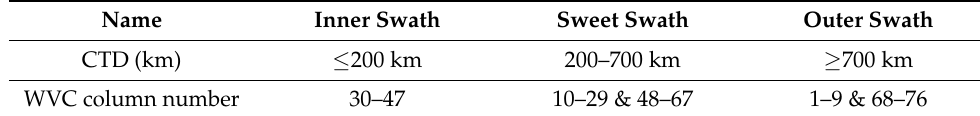
Table 1. Swath categorization for the HSCATs.